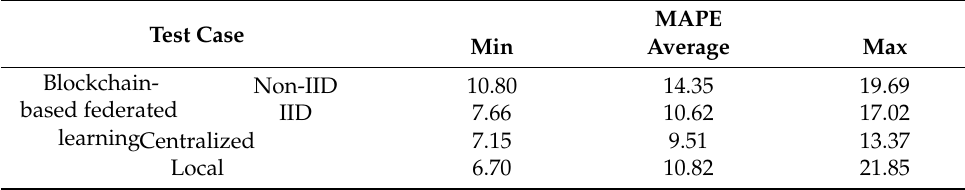
Table 5. Accuracy of the prediction